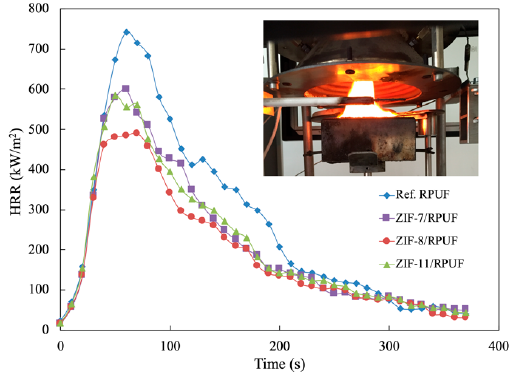
Figure 7. HRR curves of Ref. RPUF, ZIF-7 / RPUF, ZIF-8 / RPUF and ZIF-11 / RPUF.